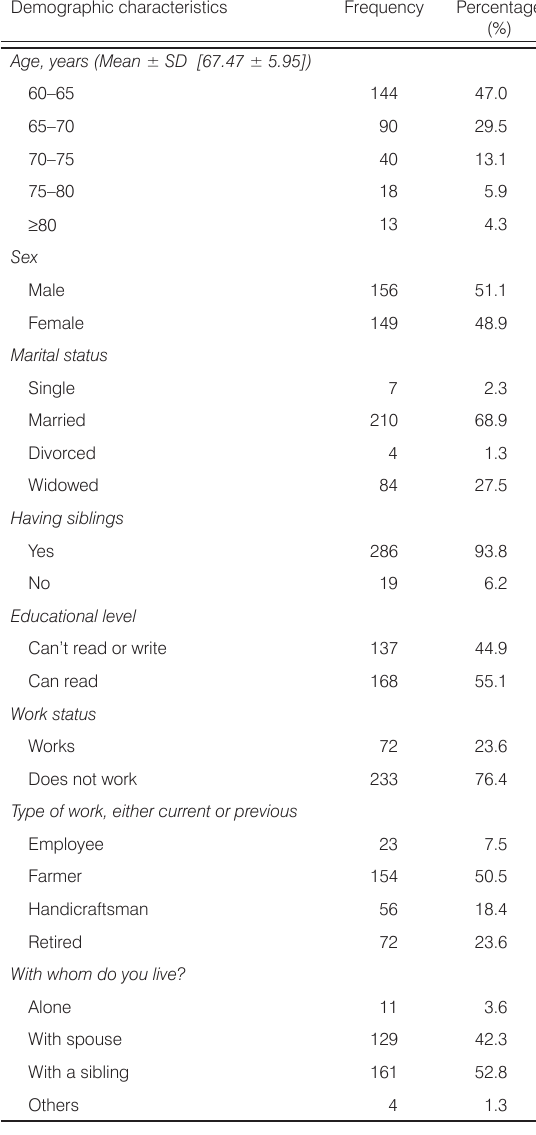
Table 1. Distribution of the study subjects regarding demographic data of the elderly (N = 305).